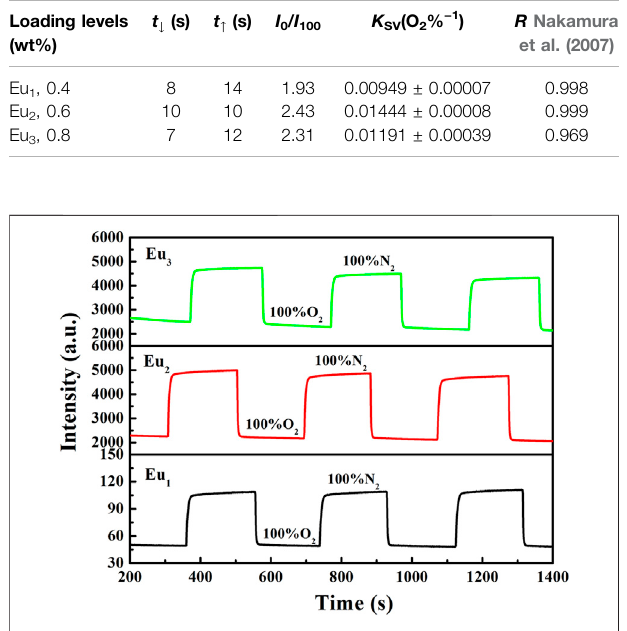
FIGURE 12 | Response time of Eu 1 , Eu 2 , and Eu 3 upon various environmental atmospheres, emission (cid:2) 610